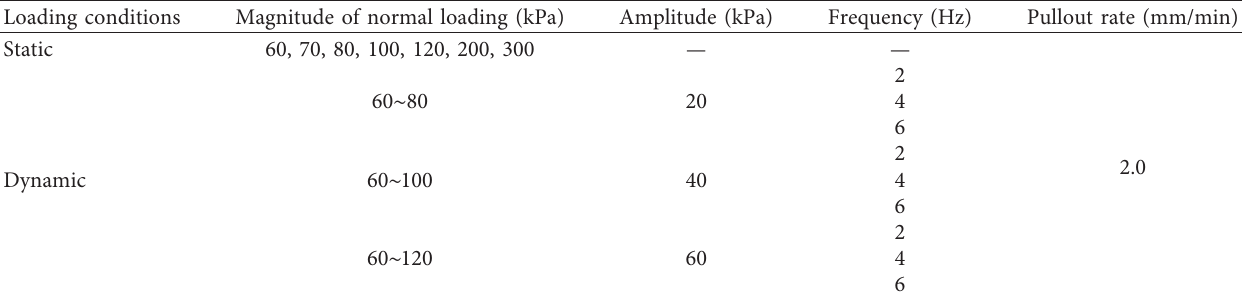
Figure 4: The experimental loading process curve under different loading conditions: (a) static loads; (b) dynamic loads. Table 4: Experimental programs of static and dynamic